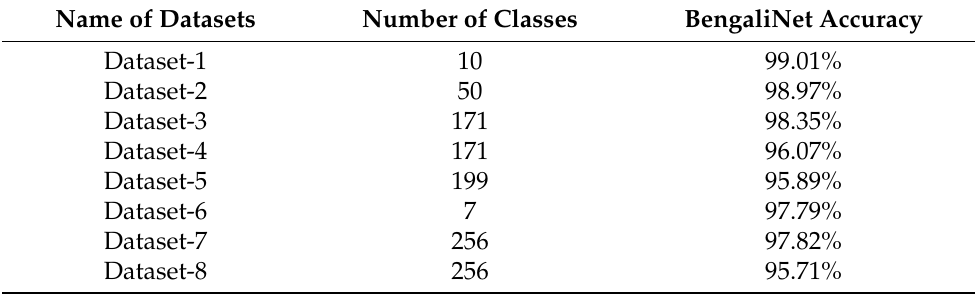
Table 4. Overall Performance of CMATERdb datasets in terms of overall accuracy.